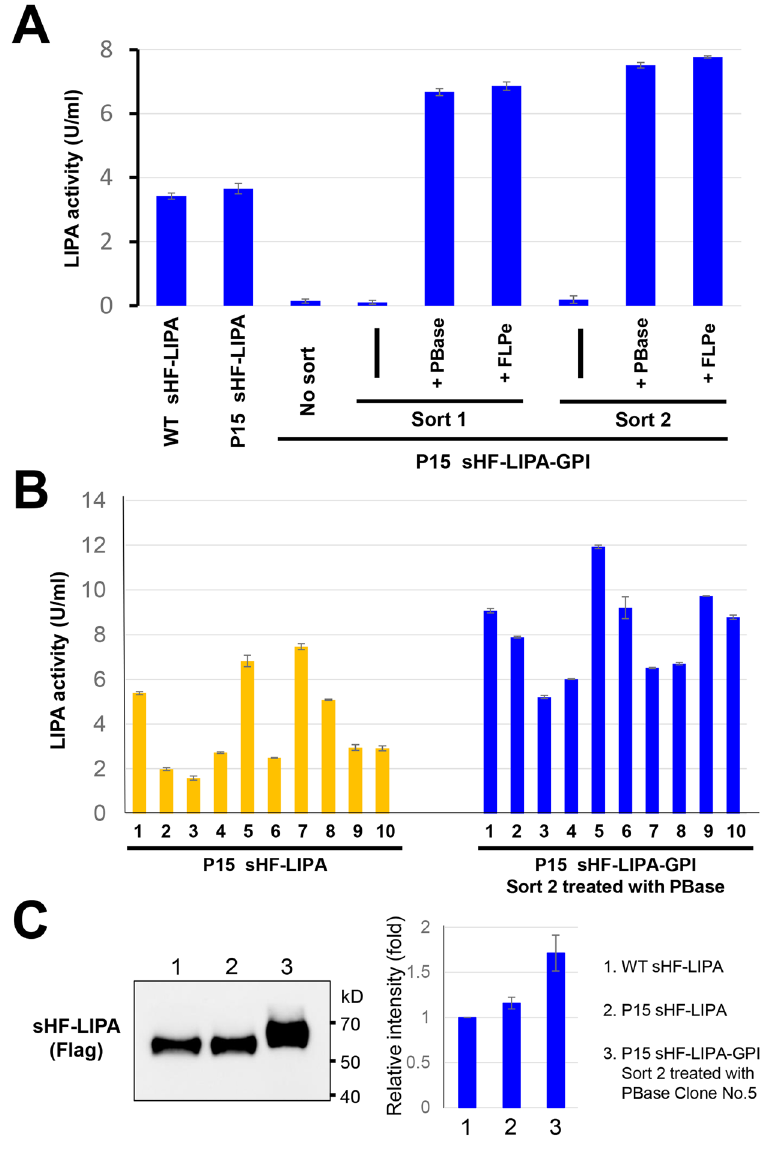
Figure 7. Secreted LIPA activities from P15 sorted cells. ( A ) LIPA activity using cell culture medium. The medium was collected after culturing 2.5 × 10 5 cells for 48 h. LIPA activities in the medium were measured by conversion of 4-NPP to nitrophenol. The values shown are means ± SD of triplicate determinants. Results represent one of three comparable experiments. ( B ) LIPA activities in single clonal cells from P15 cells stably expressing soluble sHF-LIPA and PBase-treated P15 cells expressing sHF-LIPA-GPI after two rounds of sorting. The values shown are means ± SD of triplicate determinants. ( C ) Western blot of LIPA secreted from HEK293 (WT: 1) and P15 (2) cells stably expressing soluble sHF-LIPA and clone No. 5 of the PBase-treated P15 (3) cells expressing sHF-LIPA-GPI after two rounds of sorting (left). Culture media were collected and precipitated. Proteins were detected by anti-Flag antibodies. The full image was included in the supplementary information. The relative intensity of sHF-LIPA in the western blot was plotted. The intensity of the sHF-LIPA expressed from WT cells was set as 1. The values shown are mean ± error of two independent